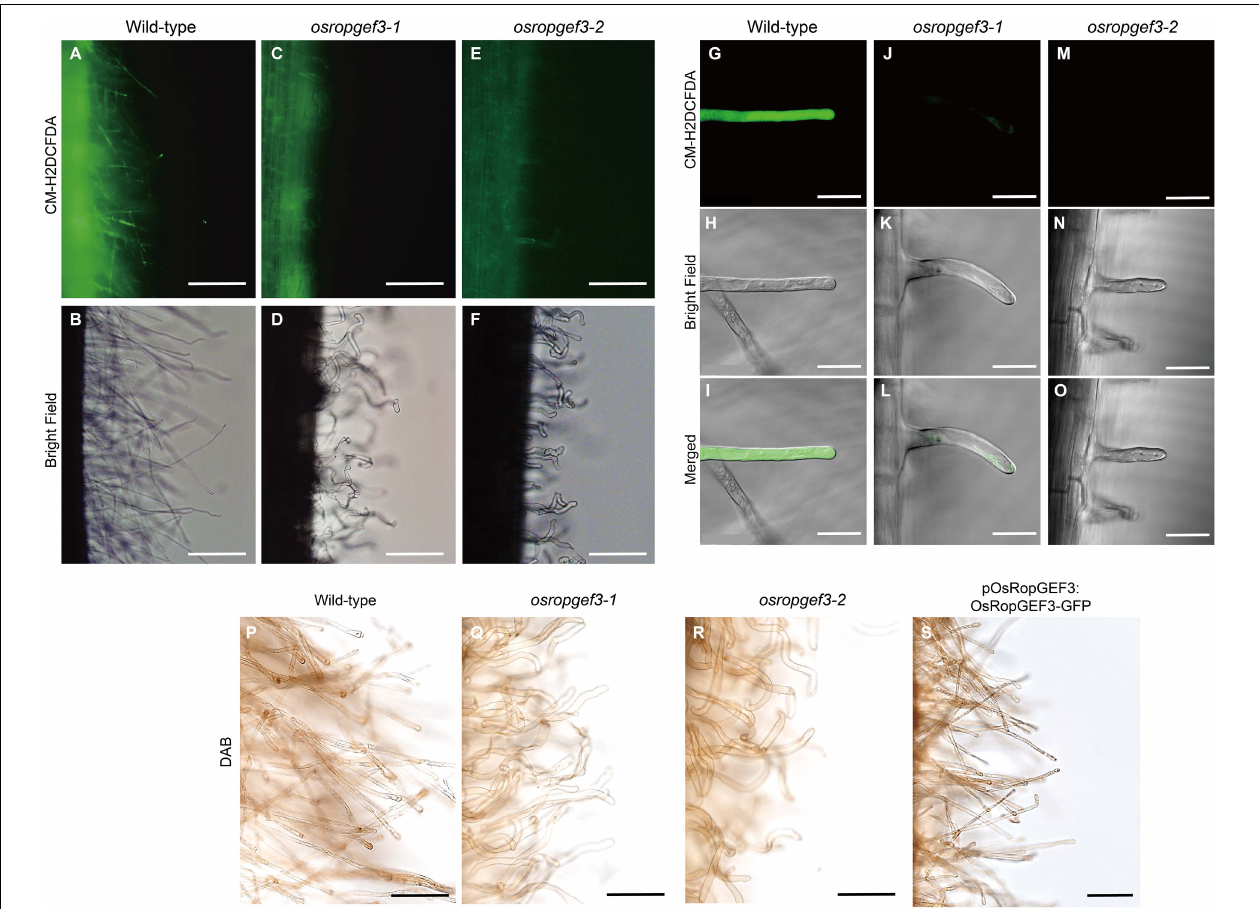
FIGURE 4 | The difference in reactive oxygen species (ROS) in the root hairs of wild-type, osropgef3 mutants, and gain-of-function line. Representative confocal images of the wild-type and OsRopGEF3 mutant root hairs. (A–F) Hydrogen peroxide staining using CM-H2DCFDA dye in three DAG rice roots. Bars = 100 µ m. (G–O) Zoom photo of CM-H2DCFDA staining using a confocal microscope. Bars = 20 µ m. (P–S) 3,3 (cid:48) -Diaminobenzidine (DAB) staining in wild-type, two loss-of-function homozygous mutants, and gain-of-function lines (pOsRopGEF3:OsRopGEF3-GFP) in the primary root of three DAG rice plants. Bars = 50 µ